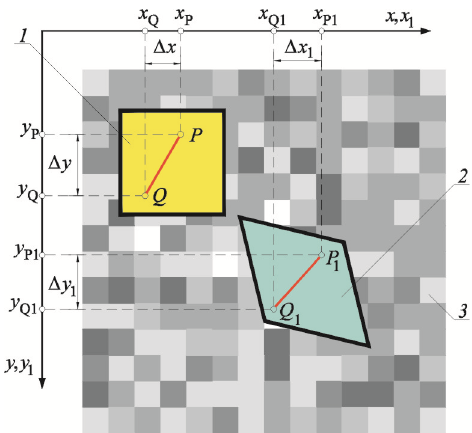
Figure 2. Graphical interpretation of deformations for selected scanning area in a 2D system of coordinates [37]: 1—scanning area, 2—scanning area after deformation, 3—pixel subimages of the structure.